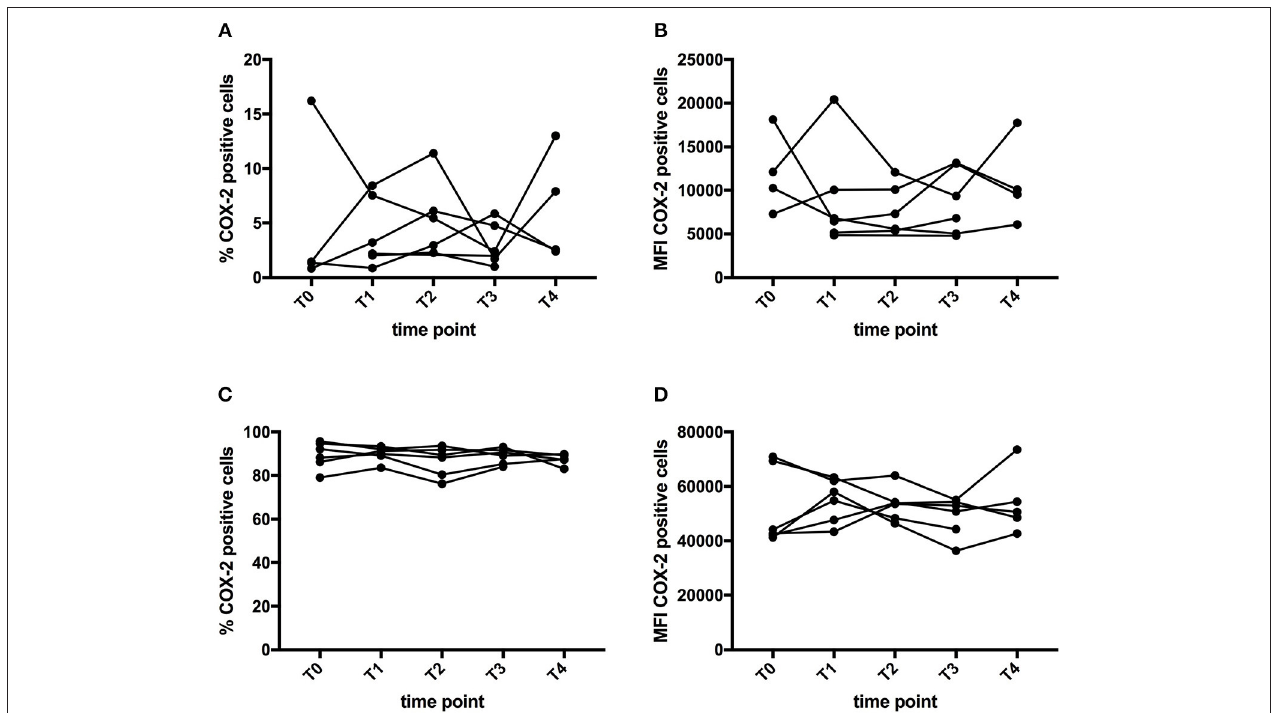
FIGURE 3 | Effect of curcumin supplementation on COX-2 expression. COX-2 expression in PBMC was determined by flow cytometry. The graphs show the expression in the monocyte (CD14 + ) gate, either expressed as percentage of cells expressing COX-2 (A,C) or as MFI of COX-2 expression levels (B,D) . (A,B)